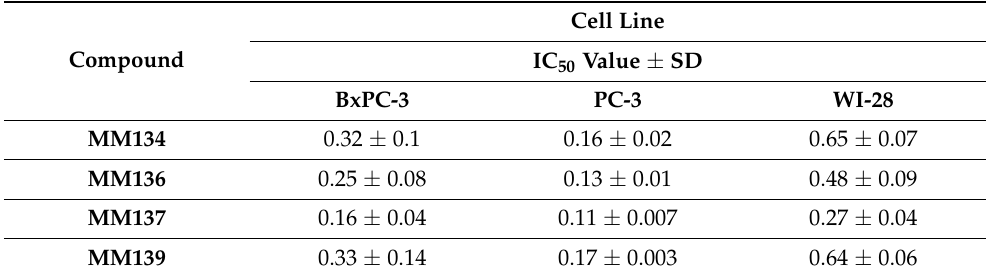
Table 2. MTT results after 72 h: mean IC 50 values ± SD obtained after 72 h incubation of cells with the tested MM compounds ( MM134 , -6 , -7 and -9 ) using MTT assay.